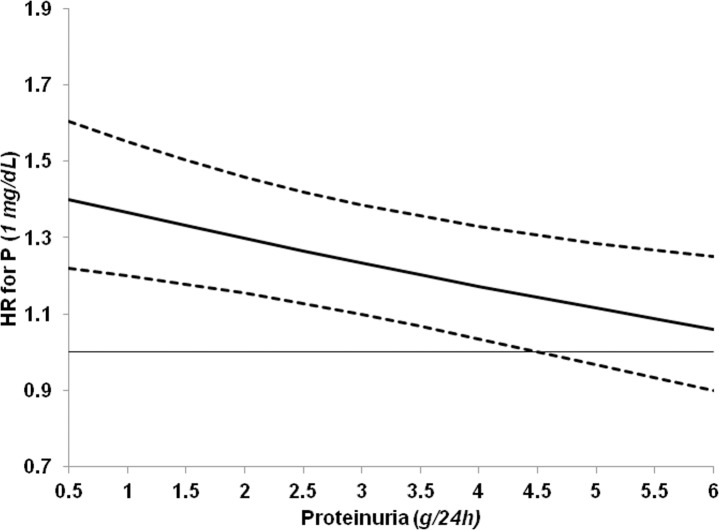
Adjusted hazard ratios (solid line) and 95% confidence intervals (dashed lines) of one-unit increase of serum phosphorus (P) by 24h proteinuria in the prediction of ESRD in control patients.The horizontal line represents hazard ratio 1. Beta value of the interaction P*Proteinuria is -0.050 (P 0.004). Hazards are stratified by cohort and CKD stage and adjusted for all covariates in Cox model reported in Table 5.